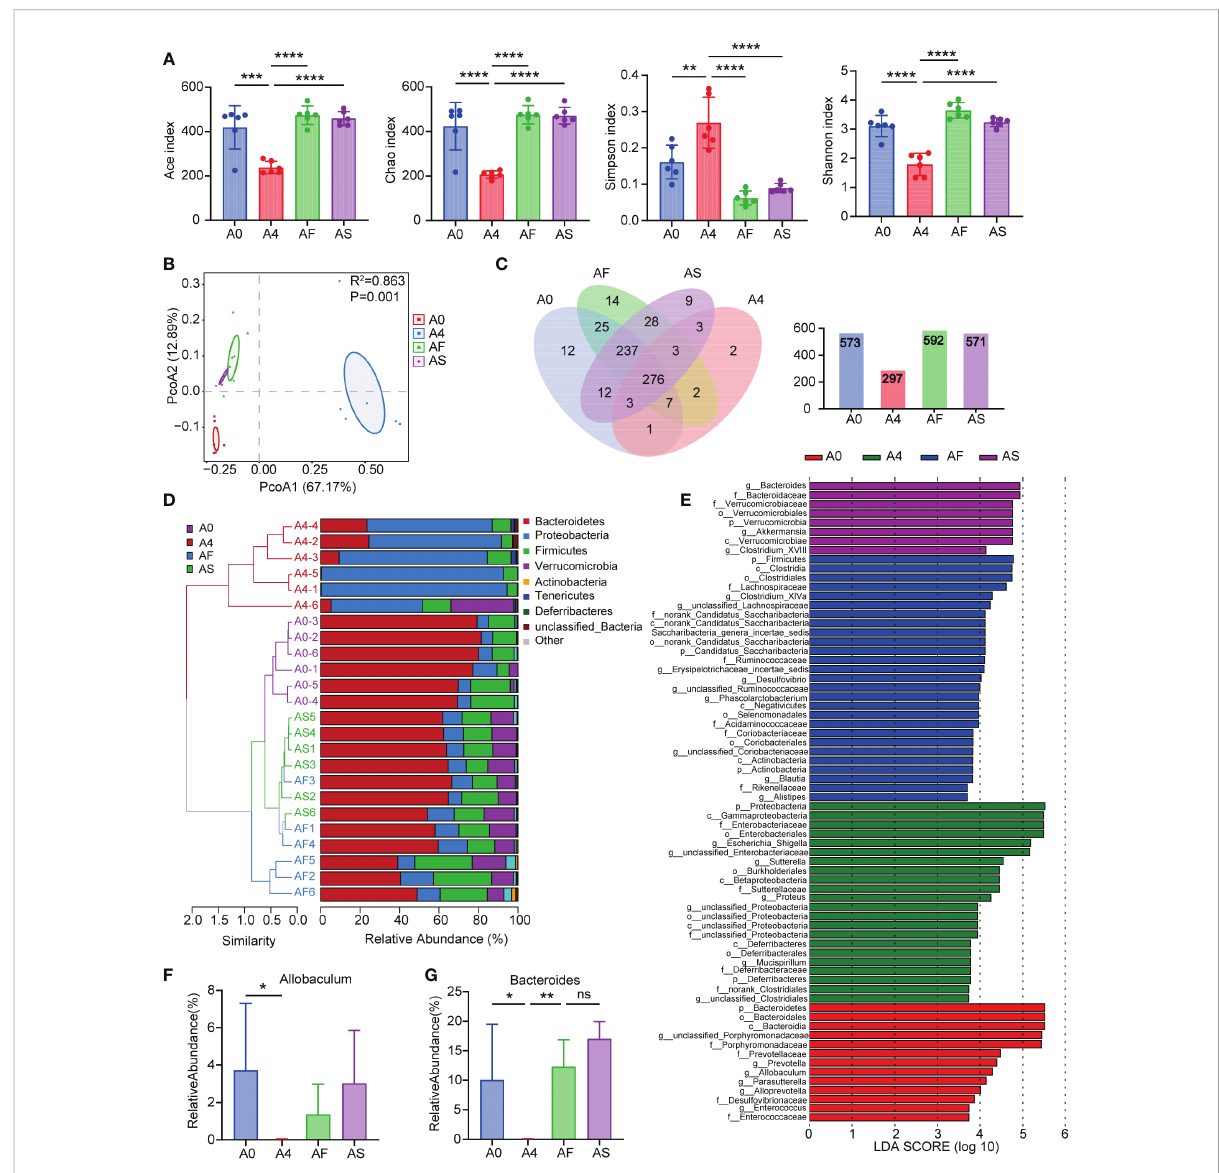
FIGURE 5 Mouse feces microbiota diversity. (A) Alpha diversity in the A0 (blue), A4 (red), AF (green), and AS (purple) groups, as shown by the Ace, Chao, Shannon, and Simpson indices. (B) The beta diversity of gut microbiota was displayed by principal component analysis (PCoA) scatterplots. (C) Parallel and overlapping circles are seen in this Venn diagram. Species shared between groups are shown by the overlapping portion, while those unique to each group are shown by the non-overlapping portion. (D) Hierarchical clustering based on the Weighted Unifrac Distance of OTU pro fi les shows the community composition of each sample at the phylum level. (E) At the genus level, the abundance of species in the LEfSe for each group. The gradation of color represents the correlation value. n = 6 mice per group. (F, G) Relative abundance of SCFAs- producing bacteria in groups (F) Allobaculum (G) Bacteroides . A0 group (no antibiotics), A4 group (antibiotics for 4 days + normal saline for 3 days), AF group (antibiotics for 4 days + FMT for 3 days), AS group (antibiotics for 4 days + SCFAs for 3 days). *P < 0.05; **P < 0.01; ***P < 0.001; ****P < 0.0001. ns, not signi fi